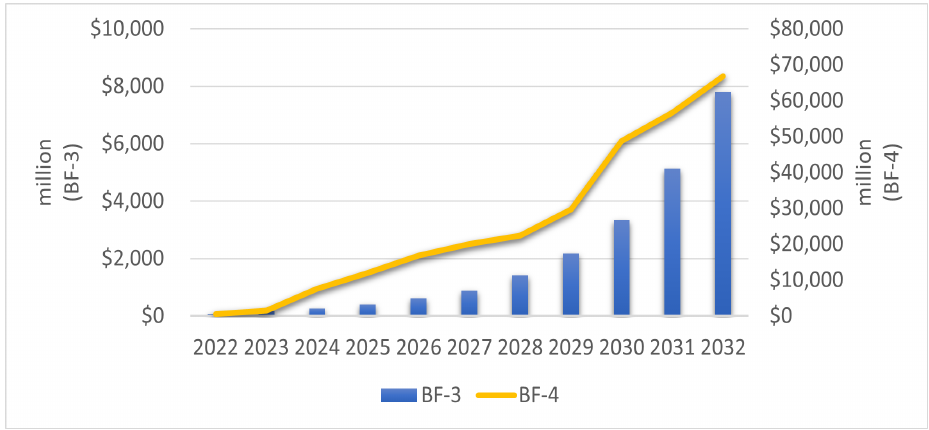
Figure 5. Yearly estimated values coming from BF-3 (see Section 4.3) and BF-4 (see Section